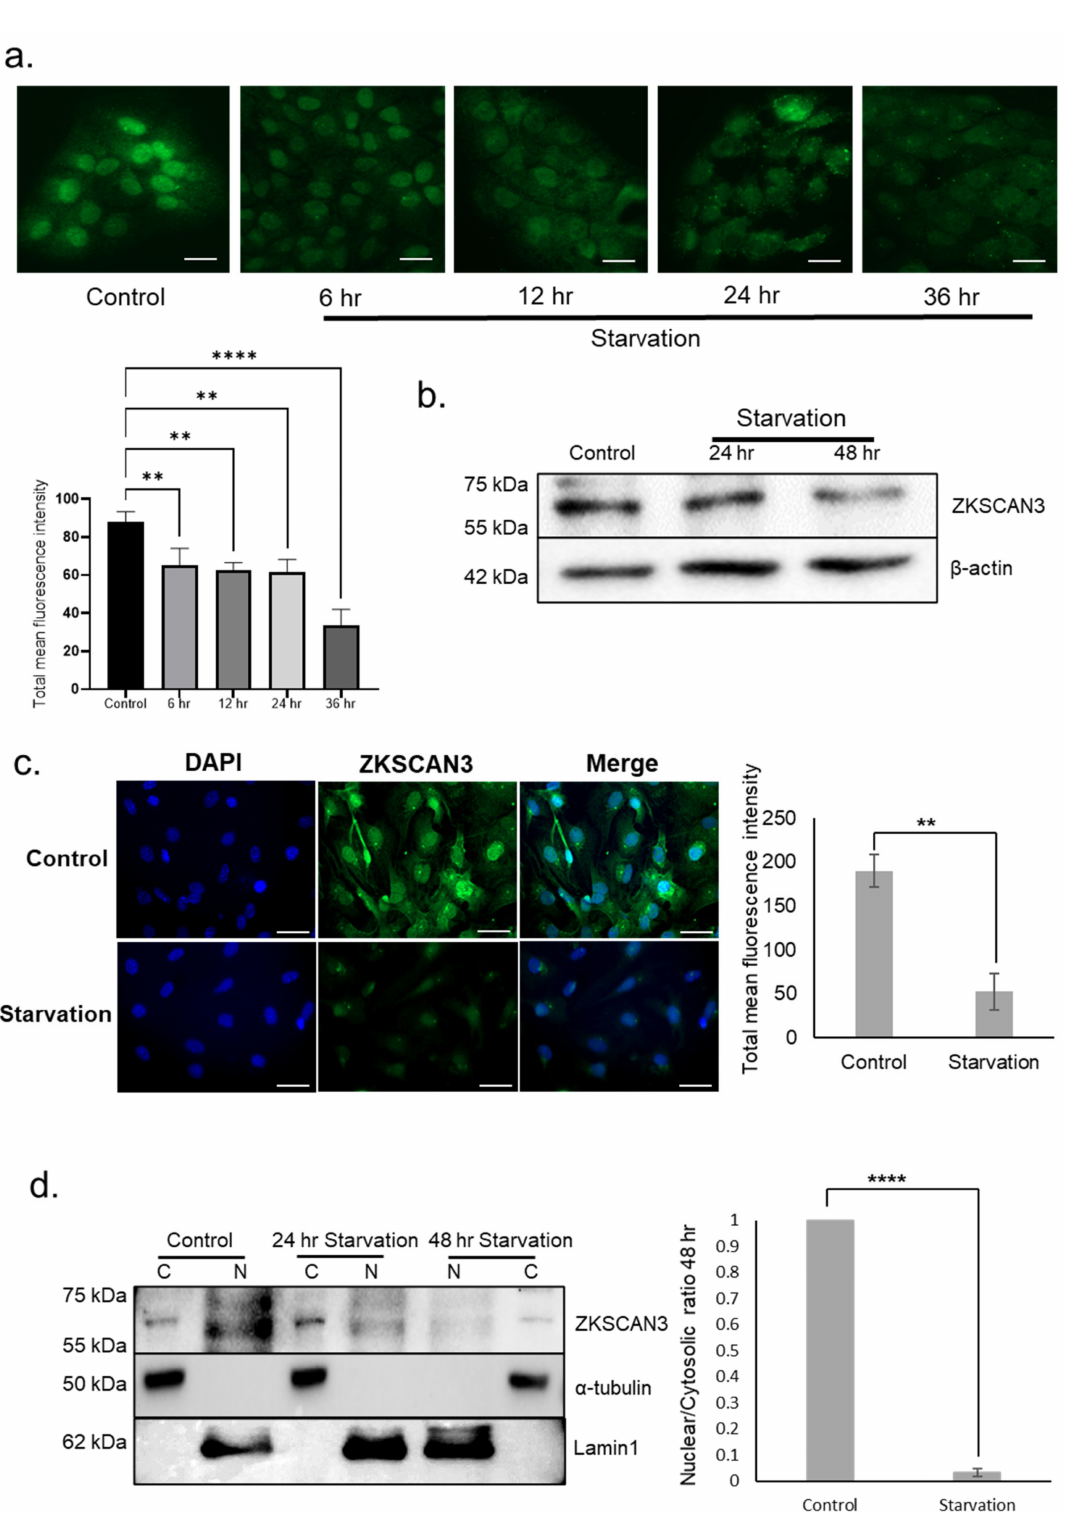
Figure 1. Nutrient deprivation results in reduced levels of ZKSCAN3 expression. ( a ) Immunostaining to determine ZKSCAN3 expression in ARPE-19; ( b ) immunoblot analysis of ZKSCAN3 expression in ARPE-19; ( c ) primary mouse RPE cells subjected to indicated periods of nutrient deprivation; ( d ) subcellular fractionation and ZKSCAN3 immunoblotting of cytosolic (C) and nuclear (N) fractions in cells subjected to nutrient deprivation. Lamin A and α -tubulin were used as controls for nuclear and cytosolic extracts, respectively. All data are presented as mean ± standard deviation. One-way ANOVA and student’s t -test (two tailed) were used for analysis p -value. The p -value is stated as ** p < 0.01, **** p < 0.0001. Scale = 20 µ